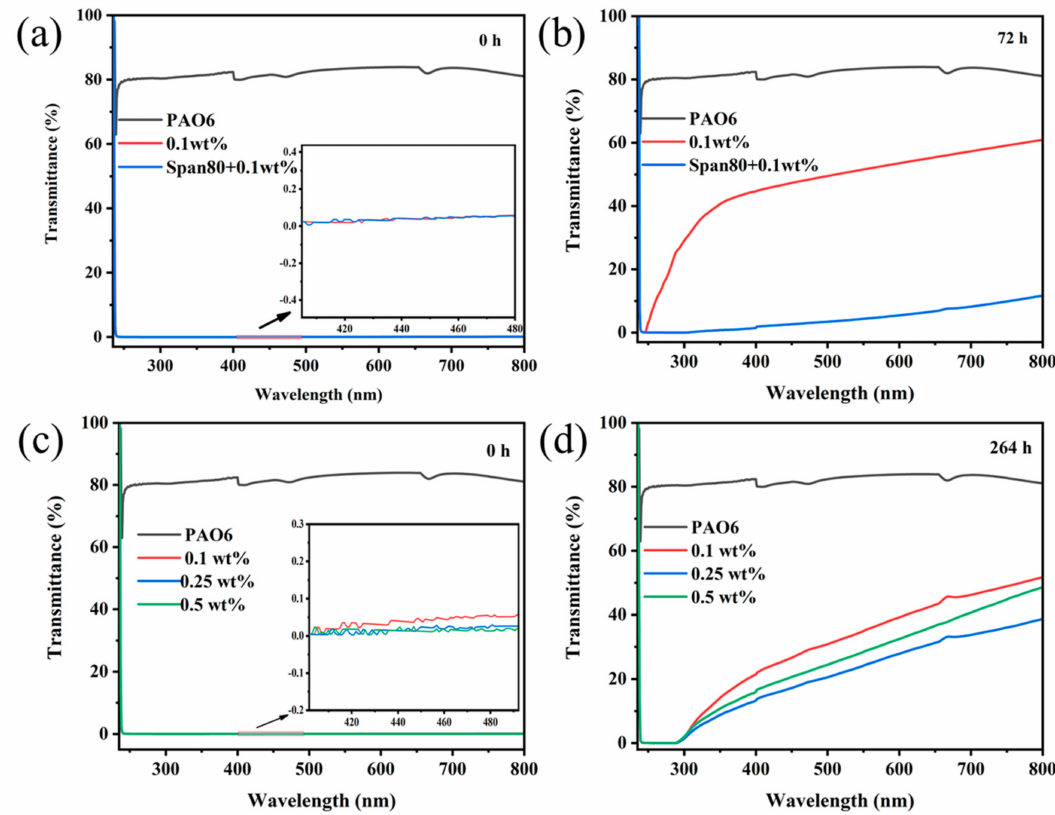
Figure 11. UV spectra of Span80-dispersed 0.1 wt% MnO 2 @h-BNNs/PAO6 lubricant ( a , b ) and different concentrations of MnO 2 @h-BNNs/PAO6 ( c , d